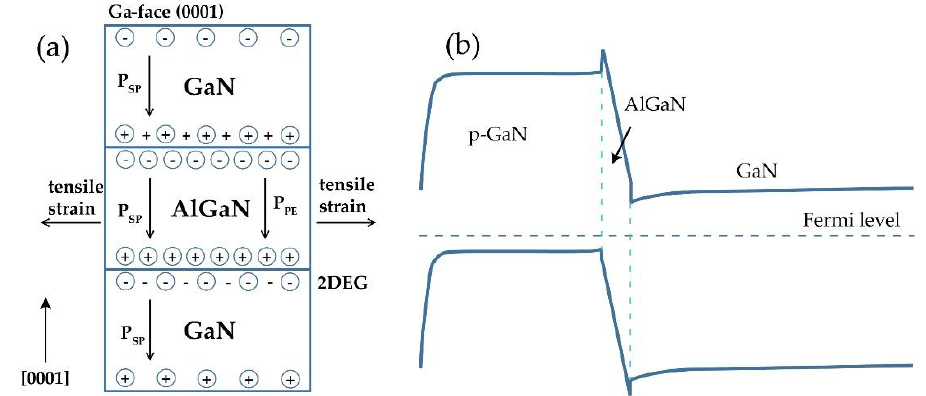
Figure 8. The schematics of ( a ) polarizations of AlGaN/GaN structure and ( b ) energy bands profile of the p-GaN HEMTs.